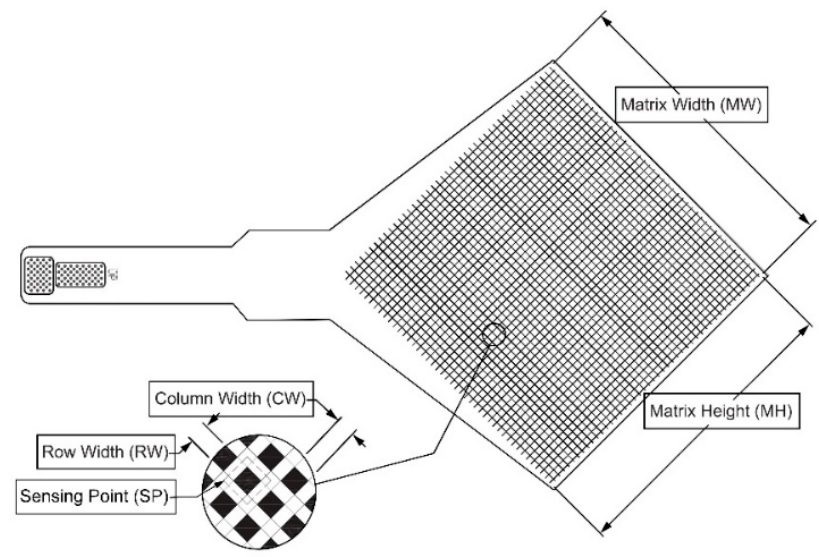
Figure 3. Structure diagram of Tekscan 5250-type tactile pressure sensor.